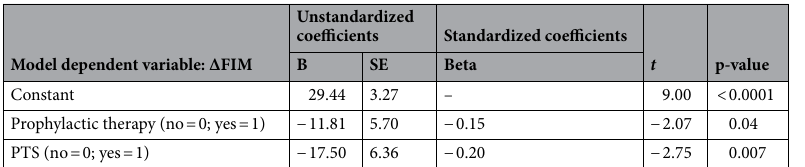
Table 7. Multiple linear regression analysis showing independent predictors for ΔFIM. FIM functional independence measure, PTS post-traumatic seizures, T1 at discharge.